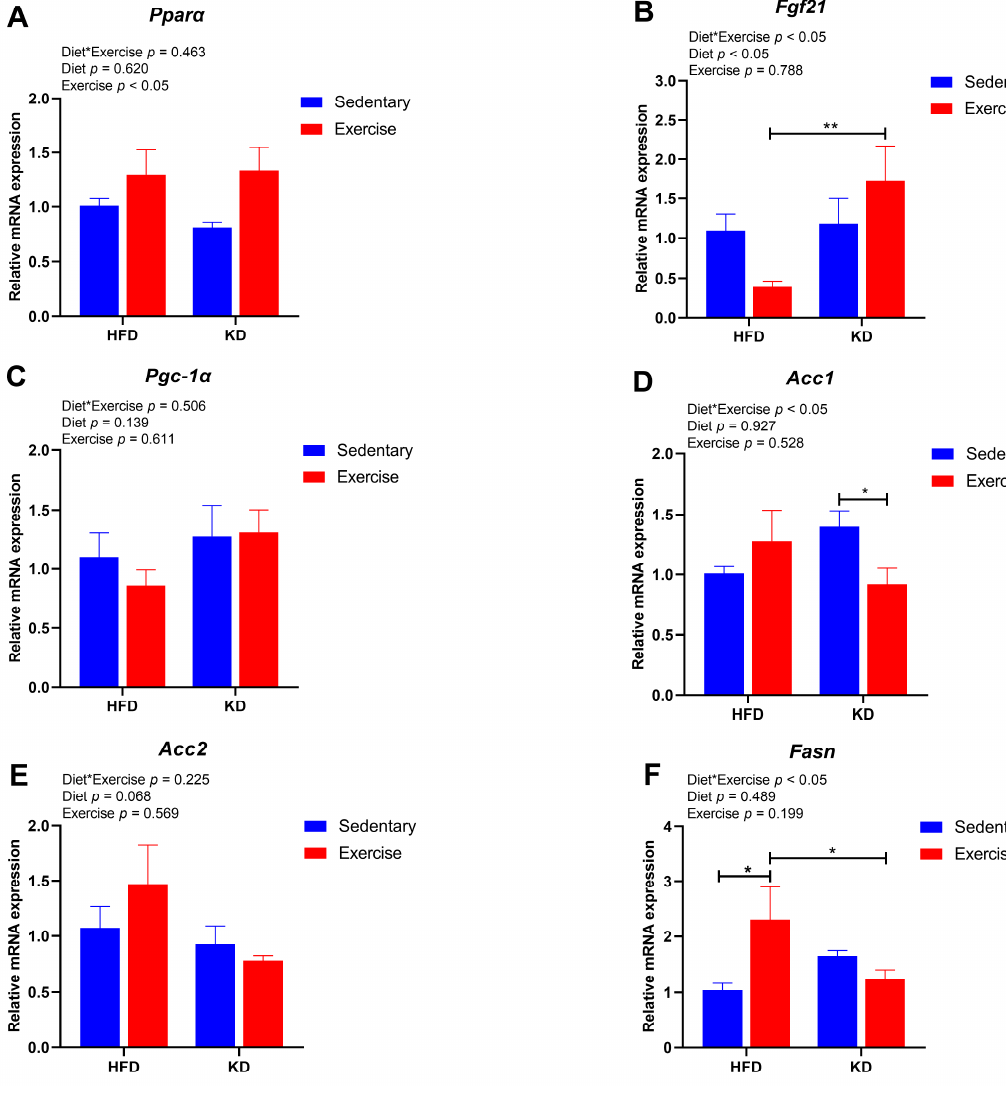
Figure 6. Effects of KD intervention and KD combined with exercise on the fatty acid oxidation and synthesis-related gene expression in livers. Gene expression of ( A ) Ppar α , ( B ) Fgf21 and ( C ) Pgc-1 α , related to fatty acid oxidation in each group of mouse livers. Gene expression of ( D ) Acc1 , ( E ) Acc2 and ( F ) Fasn , related to fatty acid synthesis in four group mouse livers. Data are presented as mean ± SEM, n = 6. For panels ( A – F ), p values from the two-way ANOVA (i.e., main diet and exercise effects and diet*exercise interactions) are presented in the top left corner; Bonferroni post hoc test indicated significant differences (identified with an asterisk) at the following p values, * p < 0.05; ** p <